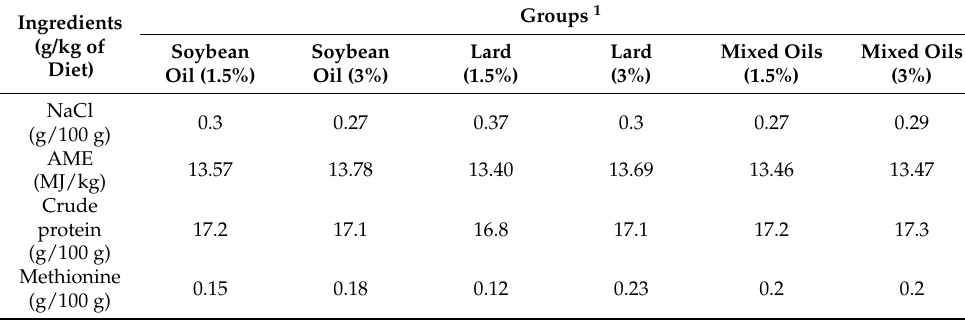
Table 2. Ingredients and composition of the experimental diets (as